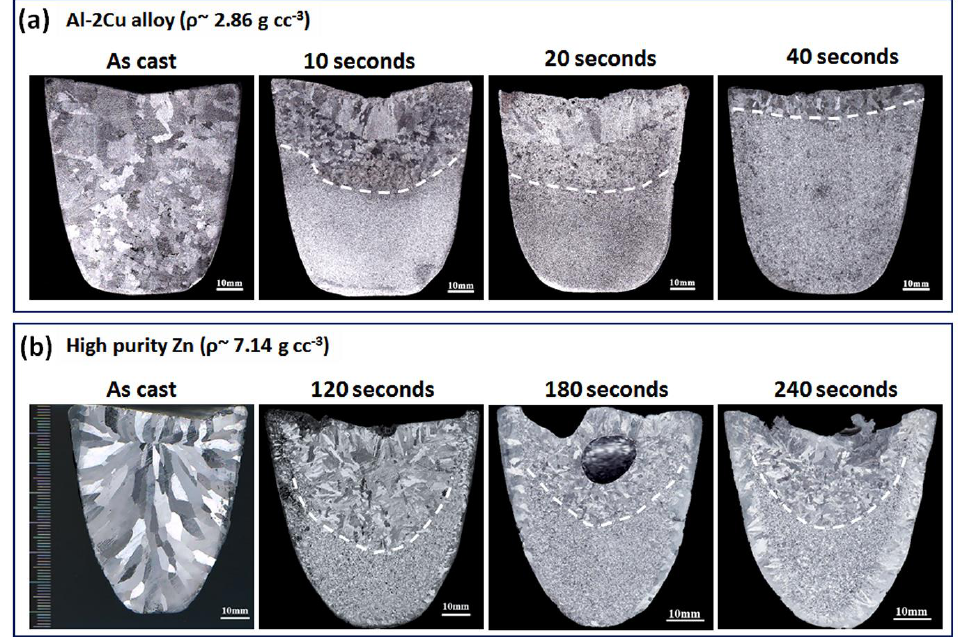
Figure 11. Settling of grains when UST is terminated after various time periods during solidification of ( a ) Al-2Cu alloy and ( b ) high purity Zn [43,76].